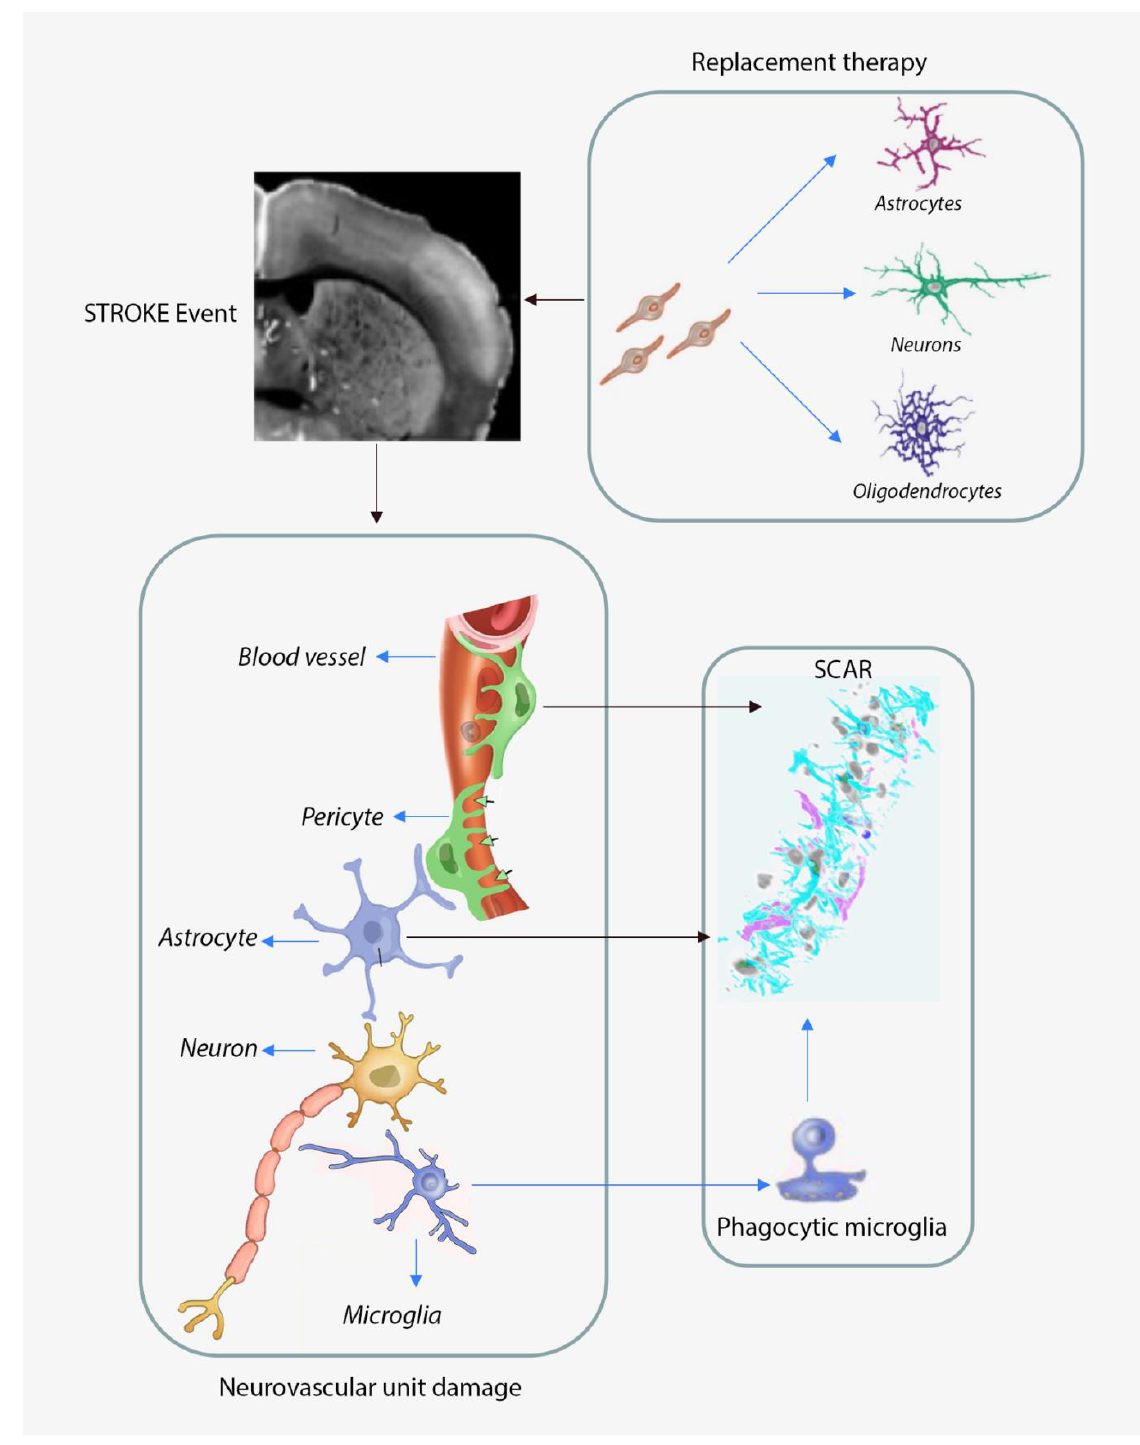
Figure 1. Under severe hypoxic conditions, the neurovascular unit disintegrate, resulting in massive neuronal death. Astrocytes and pericytes will proliferate and rush to the lesion site to build up the glial scar while the microglia will become activated and clear the neuronal and other cellular debris by phagocytosis. Blue arrows refer to cell phenotypic conversion.